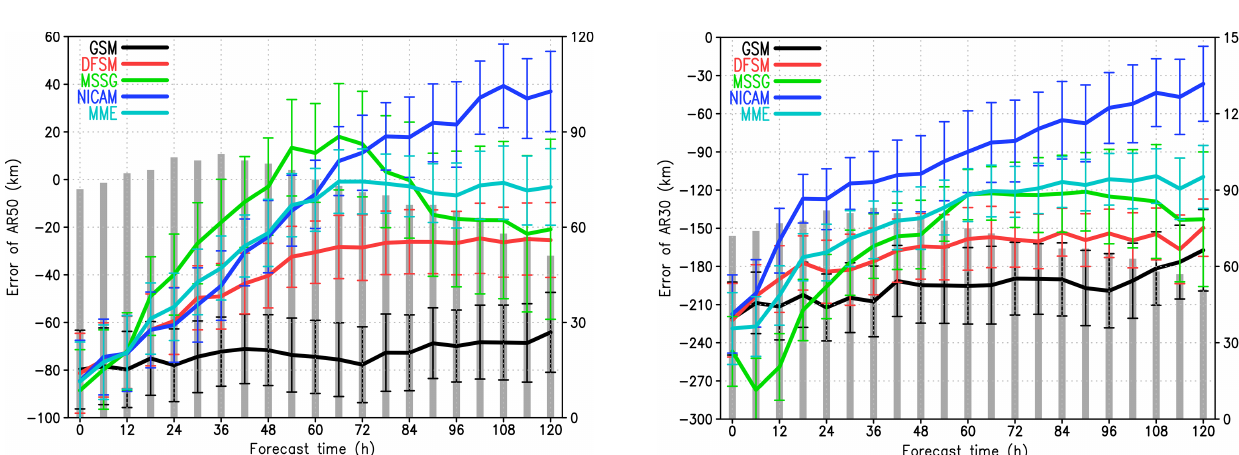
Figure 6. Errors in the averaged radius of the 30-knot wind (AR30) for GSM, DFSM, MSSG, NICAM and MME (in the second stage). Each grey bar indicates the number of samples at each forecast time (right-vertical axis). Error bars indicate 95% confidence levels of the AR30 difference between the prediction and the RSMC Tokyo best-track